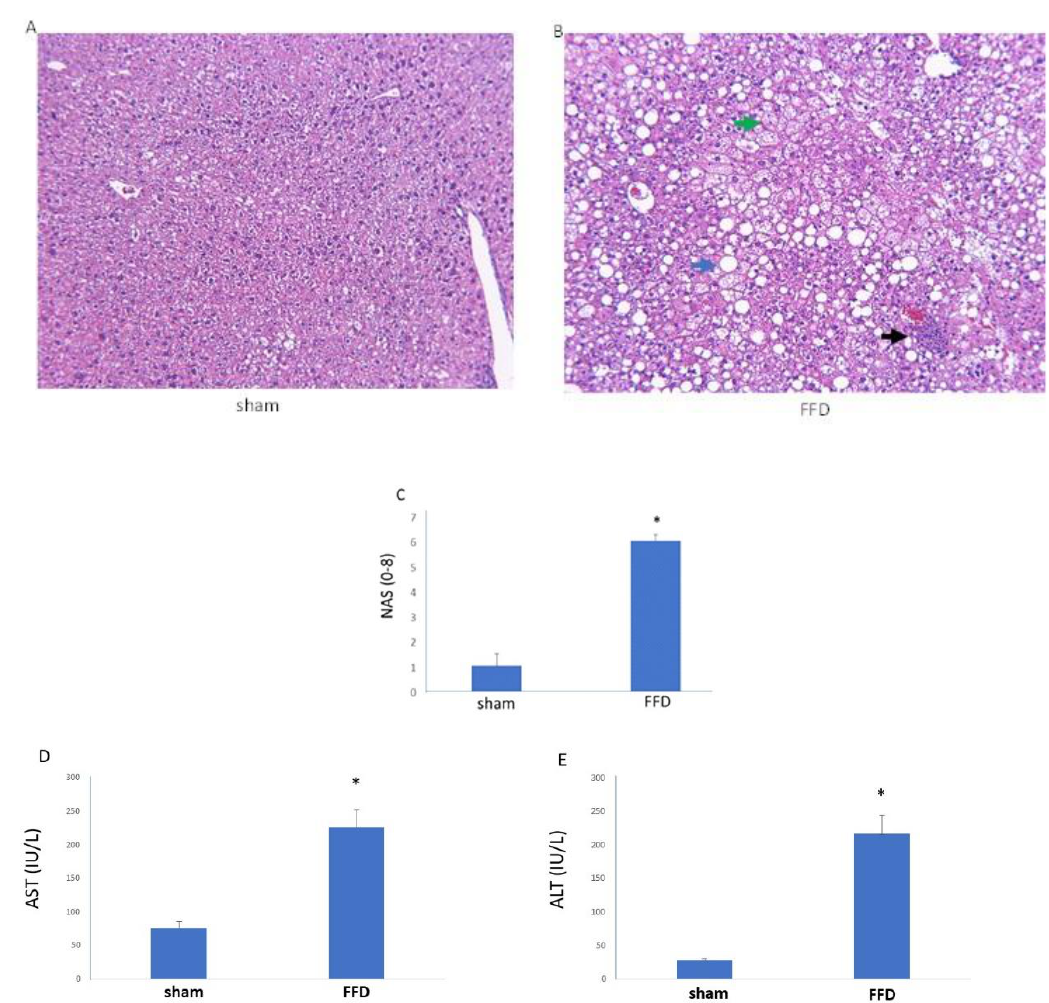
Figure 1. Characteristic Features of Nonalcoholic Steatohepatitis (NASH). Representative images (10 × of H&E-stained liver sections from mice randomized to a standard diet ( A , sham, n = 9) or FFD ( B , n =15). The blue arrow shows one of many lipid droplets, the black arrow shows a site of inflammation, and the green arrow shows hepatocyte ballooning. NAS ( C ), AST ( D ), and ALT ( E ) were elevated in the FFD cohort compared with the sham cohort. *, p < 0.01.